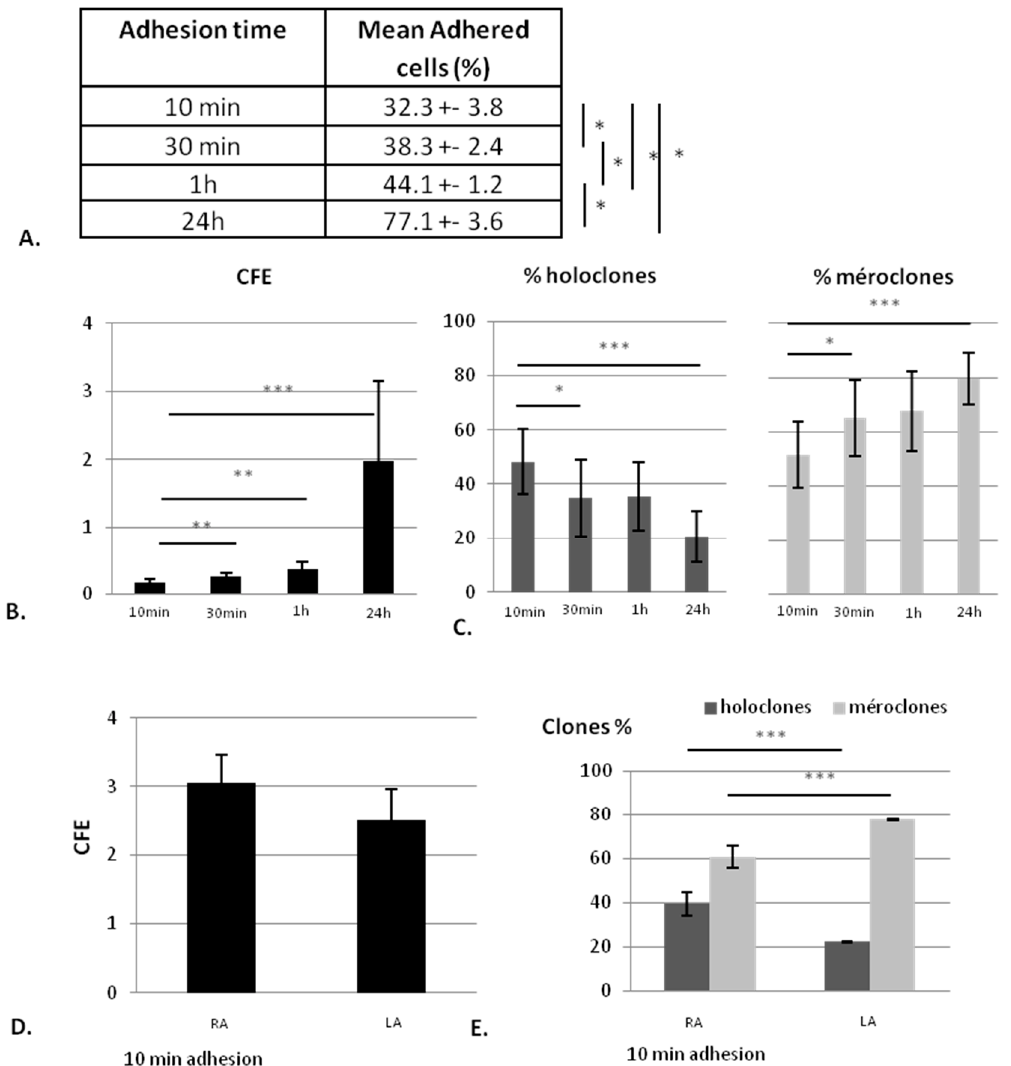
Figure 2. Influence of adhesion time on clonogenic potential of the different isolated cells (Rapid adherent (RA) and Low adherent (LA)). ( A ) percentage of adhered cells for each adhesion time; ( B ) colony-forming efficacy (CFE) obtained with different adhesion times (10 min, 30 min, 1 h and 24 h); ( C ) colony repartition (percentage of holoclones and meroclones composing colonies) from RA cells having adhered within different times; ( D ) CFE of RA cells (cells having adhered within 10 min) and LA cells; and ( E ) proportion of holoclones and meroclones containing in RA and LA cells, mean of three donors. n = 3 * data significantly different ( p < 0.05), ** p < 0.005, *** p < 0.0005.